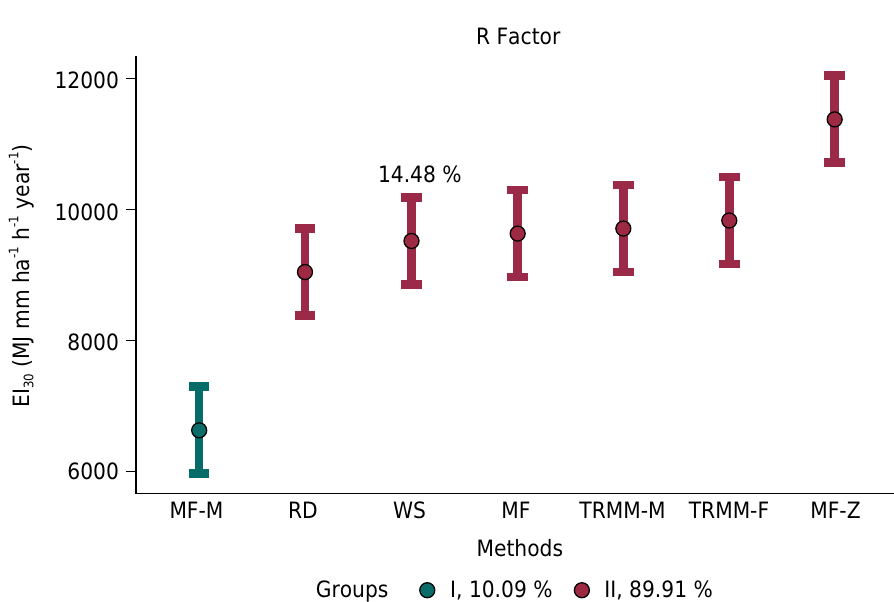
Figure 7. The univariate grouping of methods for estimation of the rainfall erosivity (R Factor), by Scott and Knott (1974), with a Chi-squared significance level of 5 %. The blue color refers to the standard method (WS), the shades of green or red were attributed to the methods that underestimate and overestimate the rainfall erosivity,